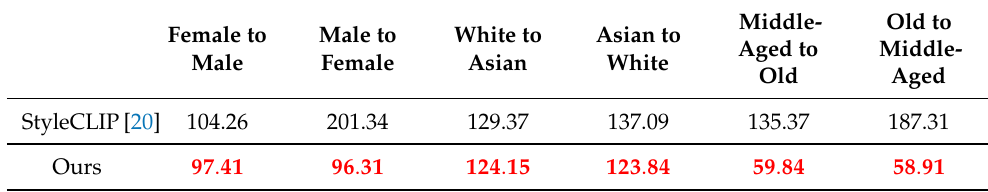
Table 8. Comparison of the average FIDs of our method and StyleCLIP. The red figures are maximum FID in each